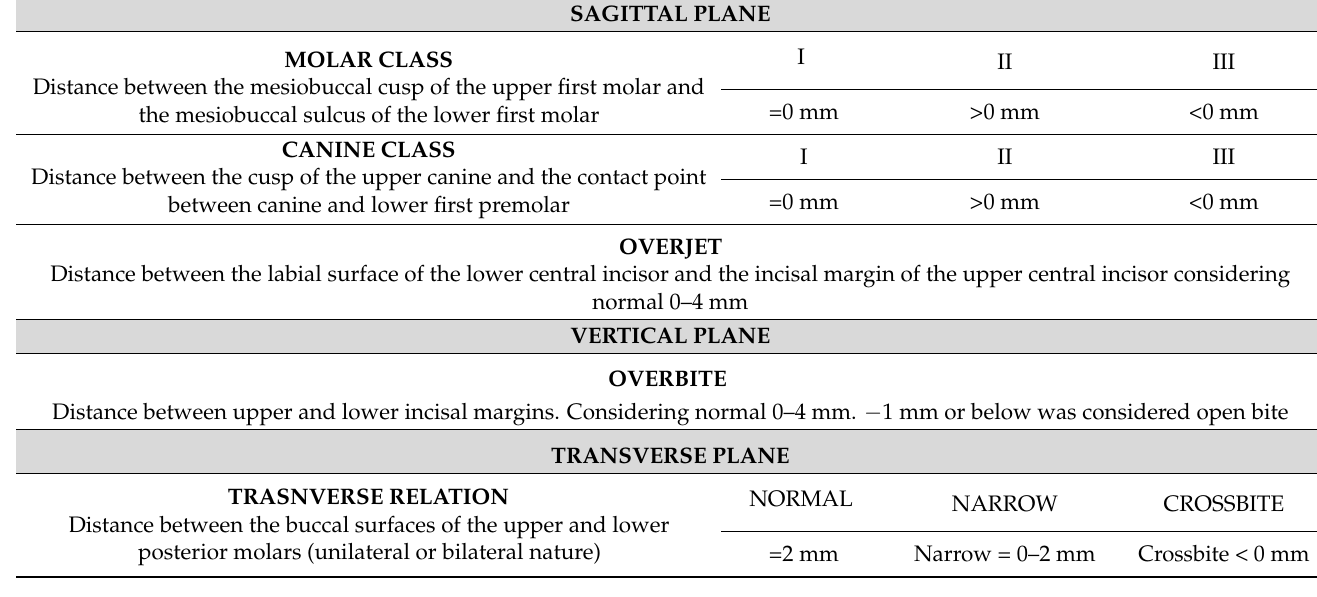
Table 1. Intraoral occlusal measurements in the three spatial planes; sagittal, vertical and